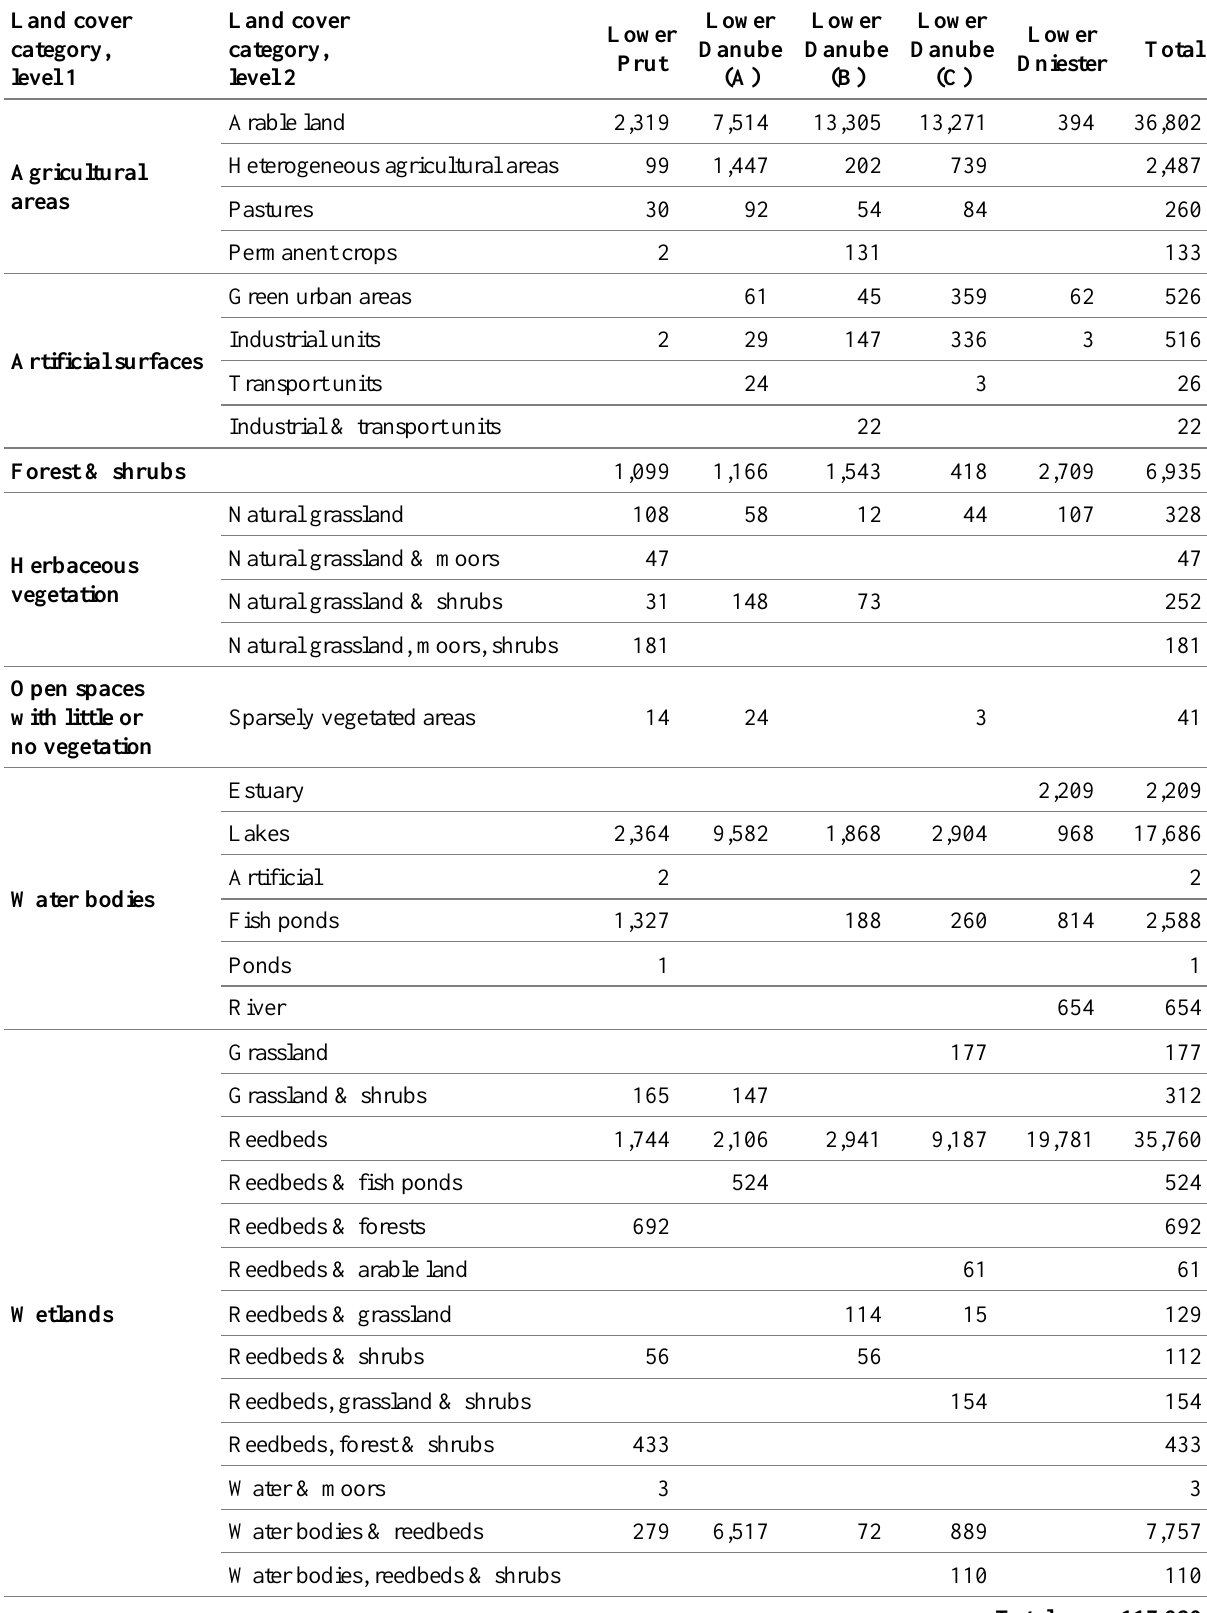
Table 1: Land cover (CORINE classification) in the project area (figures in ha, rounded). Source: ReedBASE project.